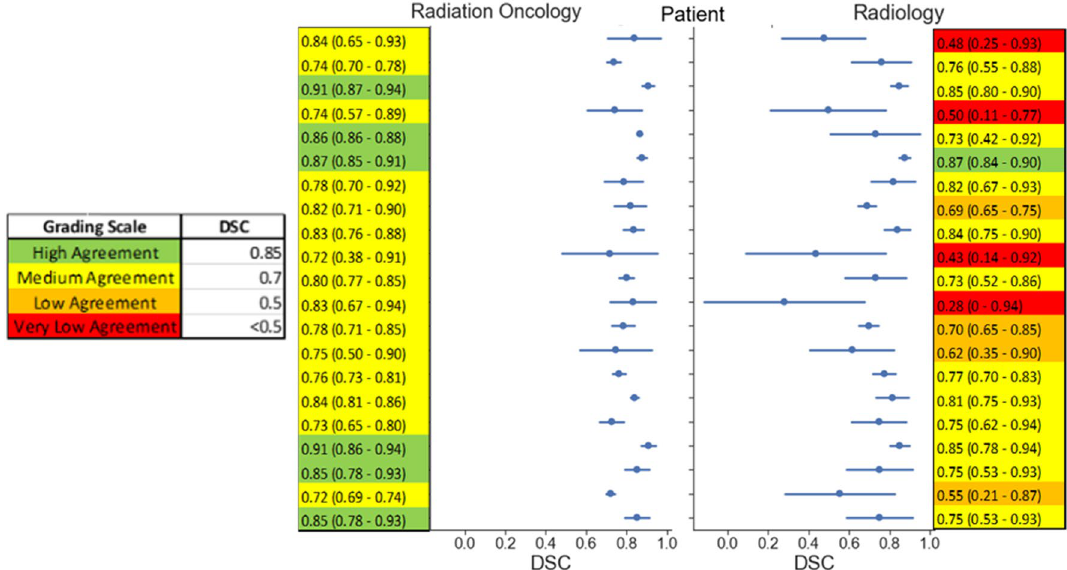
Figure 2. Dice Similarity Coefficient. Center vertical plot shows the mean DSC values (solid dot) with standard deviations (line through dot) for each CT image, separated discipline. Tables adjacent to the plot indicate the numerical values of the mean and standard deviation. DSC values were obtained by pair-wise comparison of the observer contour and STAPLE consensus contour. The legend illustrates the distribution of thresholds used to identify different levels of agreement.